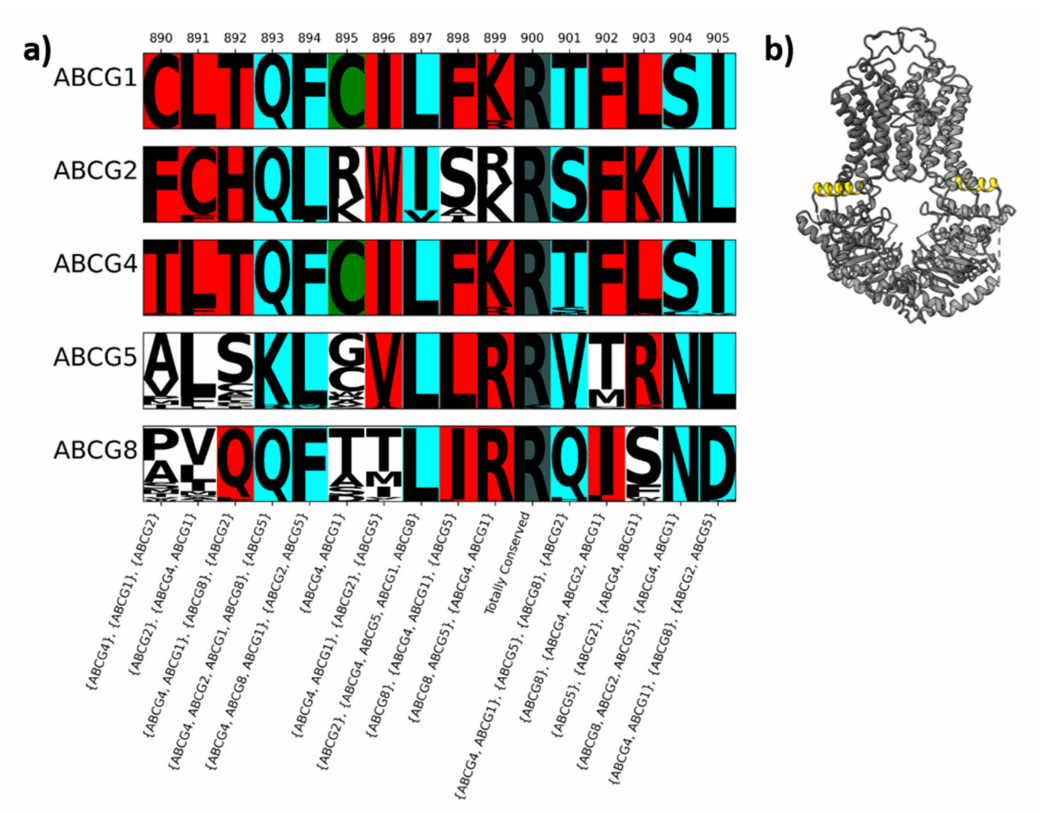
Figure 2. Conservation in the alignment of ABCG protein sequences. ( a ) Sequence logo in which sequences have been divided by the protein they represent. Font size corresponds to the fraction of sequences with that residue in that column. Conserved positions have coloured backgrounds so that totally conserved columns are grey, columns with type I divergence are green, columns with type II divergence are aqua, and columns with mixed divergence are red. Conservation patterns as described in the text are shown at the bottom. ( b ) Structure of ABCG2 (PDBID: 6vxf) highlighting the area represented in the logo. This corresponds to the elbow helix in